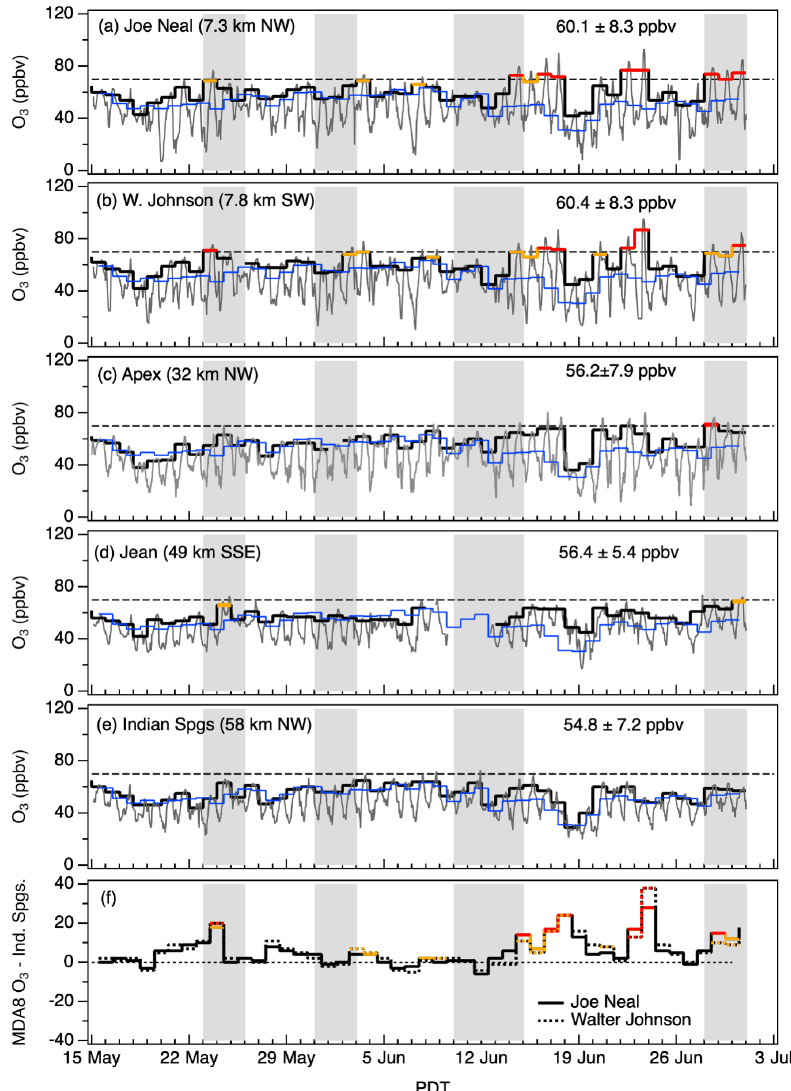
Figure 20. Time series of the 1h (gray line) and MDA8 (black staircase) O 3 measurements from the CCDAQ (a) Joe Neal, (b) Walter Johnson, (c) JD Smith, (d) Jean, and (e) Indian Springs monitors. The distances from the NLVA are shown in parentheses. Note that the Jean monitor was offline 9–12 June. The blue lines show the baseline MDA8 O 3 estimated from the mean of the NVDEP measurements. Panel (f) plots the differences between the Indian Springs monitor and the Joe Neal (solid) and Walter Johnson (dotted) monitors. MDA8 O 3 concentrations exceeding the 2015 NAAQS of 70ppbv (dashed line) and a potential NAAQS of 65ppbv are highlighted in red and orange, respectively. The gray bands show the four IOPs. The mean concentrations ( ± 1 σ ) are calculated from the 15 May to 30 June MDA8